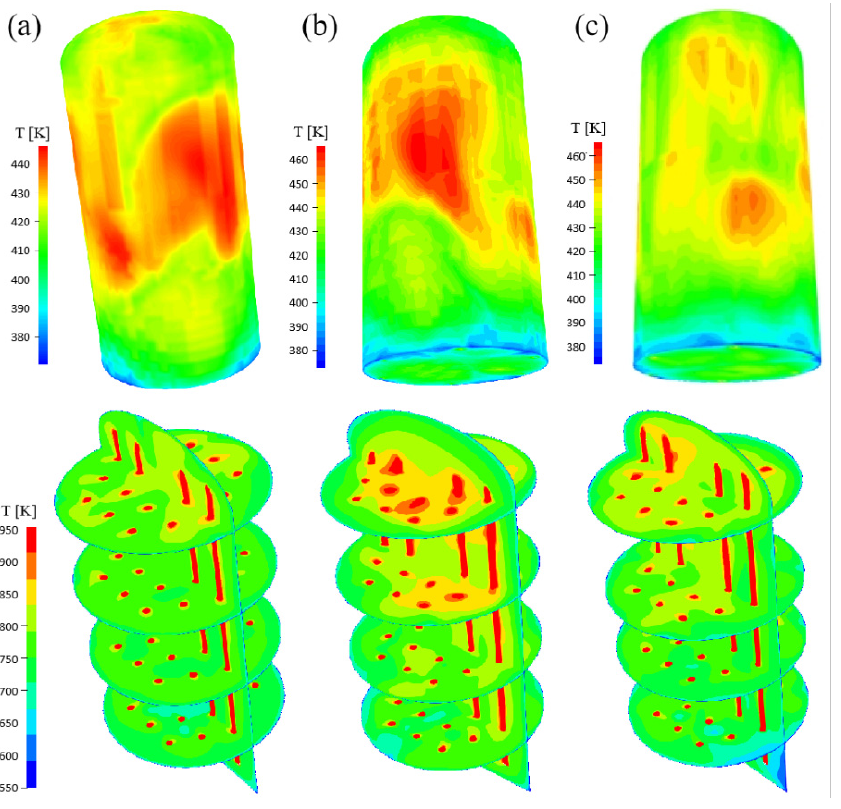
Figure 4. Temperature distribution of furnaces. ( a ) Design A; ( b ) design B; ( c ) design C.